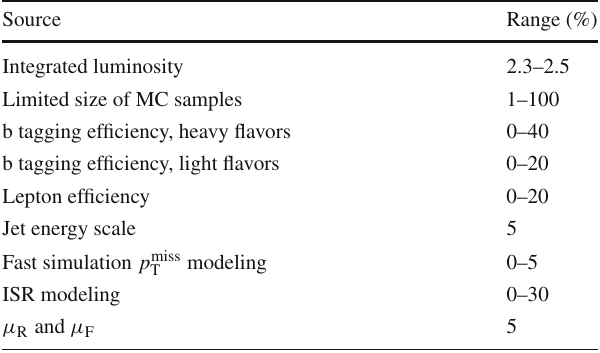
Table 7 Systematic uncertainties in the signal yields for the simpli- fied models of BSM physics. The large statistical uncertainties in the simulated signal sample come from a small number of bins with low acceptance, which are typically not among the most sensitive bins con- tributing to a given model benchmark point